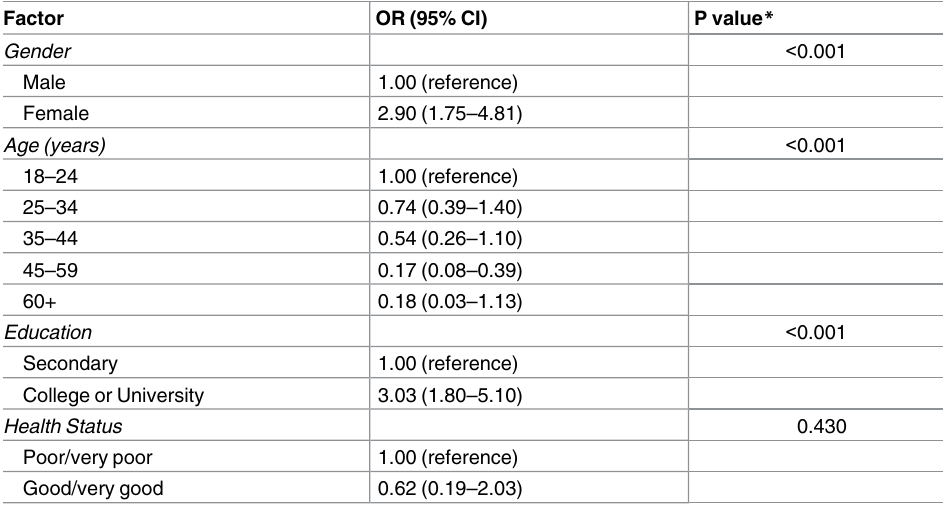
Table 3. Indicators of online health information